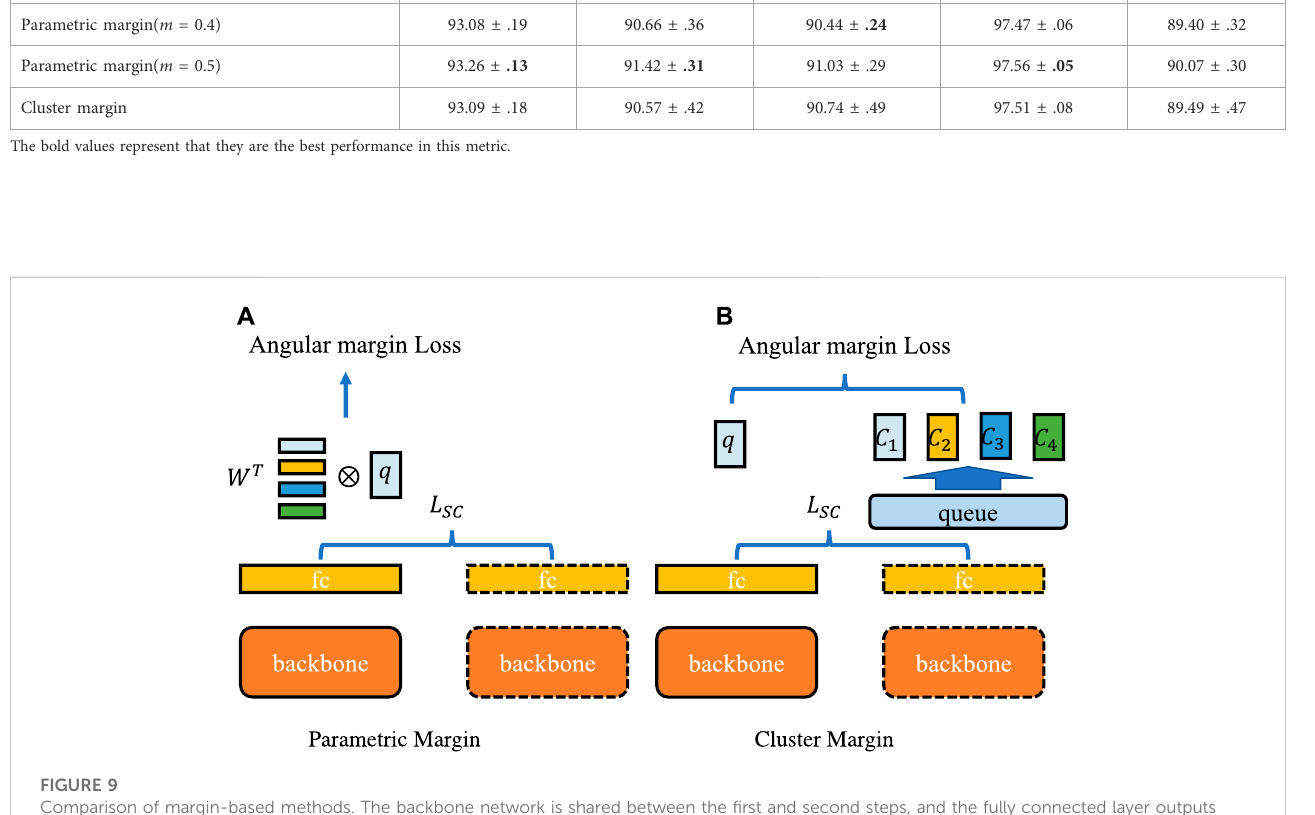
Parametric margin( m = 0.2) Parametric margin( m = 0.3) Parametric margin( m = 0.4) Parametric margin( m =